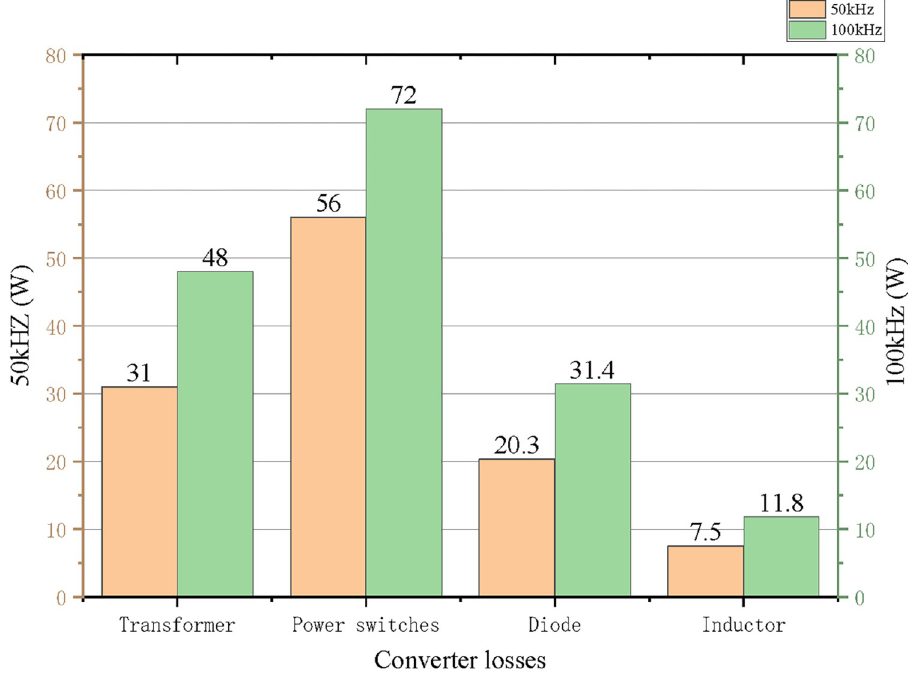
Fig 31. The diagram of component loss.